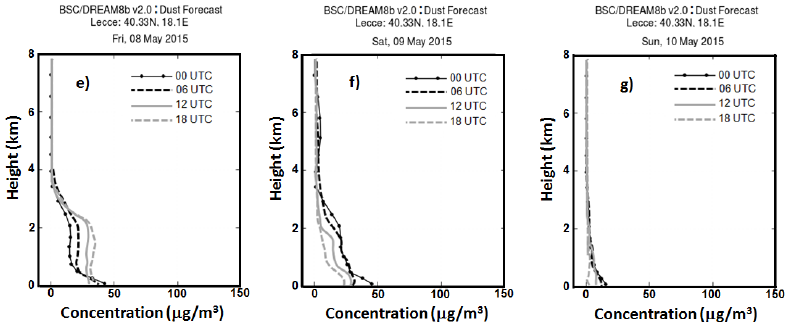
Figure 3. Dust concentration versus the height above sea level at 12:00 a.m. (black solid line), 6:00 a.m. (black dotted line), 12:00 p.m. (grey solid line), and 6:00 p.m. UTC (grey dotted line) of ( a ) 4, ( b ) 5, ( c ) 6, ( d ) 7, ( e ) 8, ( f ) 9, and ( g ) 10 May 2015, respectively, from the BSC-DREAM8b model.